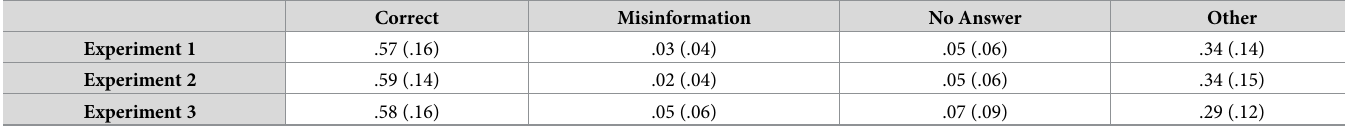
Table 2. Mean probabilities (and standard deviations) of correct, misinformation, other and no answers on the initial test in experiments 1, 2, and